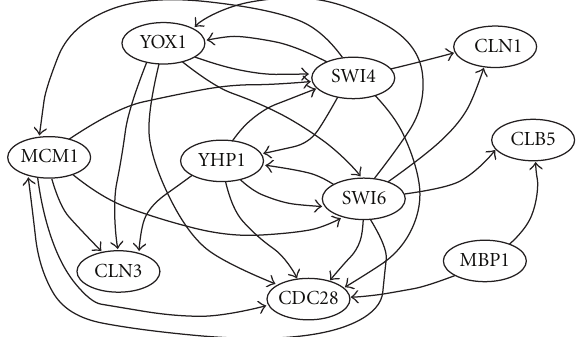
Figure 4: Structure of part of yeast cell cycle network. 9 × 10 = 90 possible edges (excluding self loops), the expected number of corrected edges is roughly estimated as